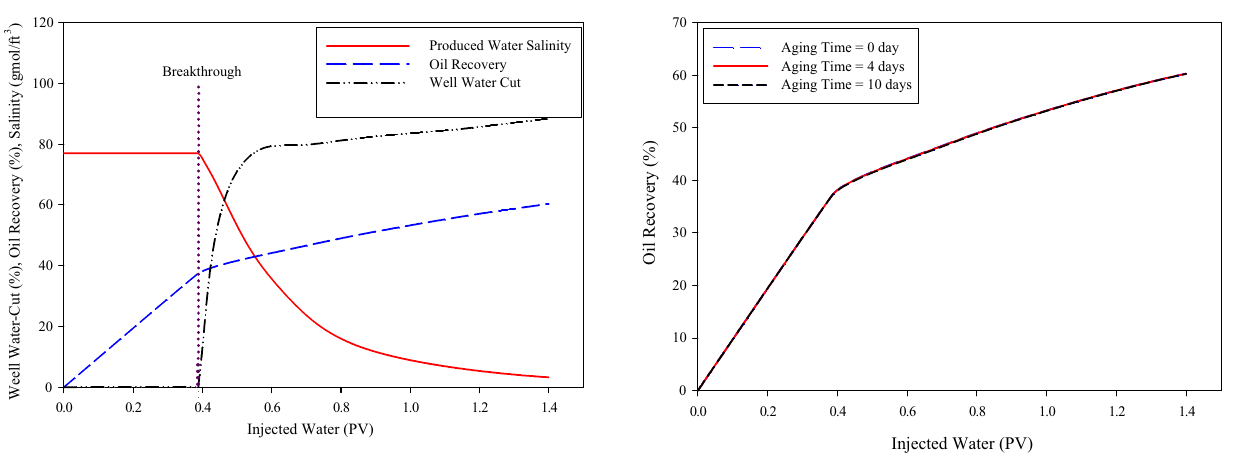
Fig. 12 Effect of aging time in wettability alteration process on